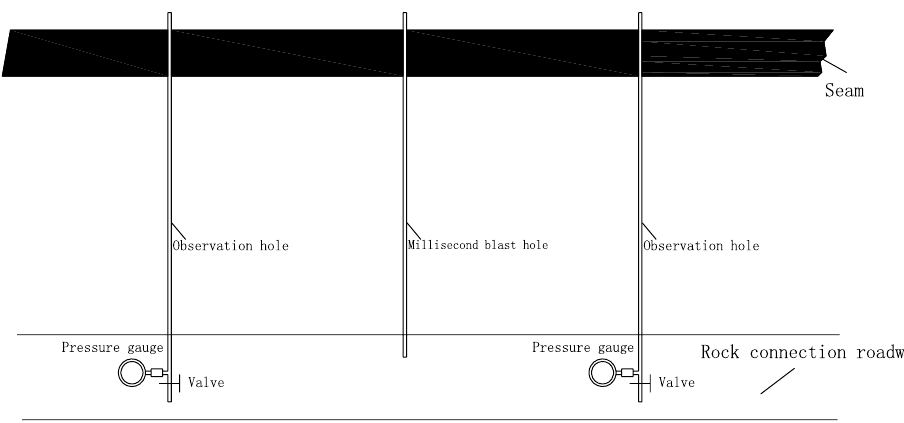
Figure 11. Schematic diagram of the drilling of coal seam permeability coefficient construction at the test site.